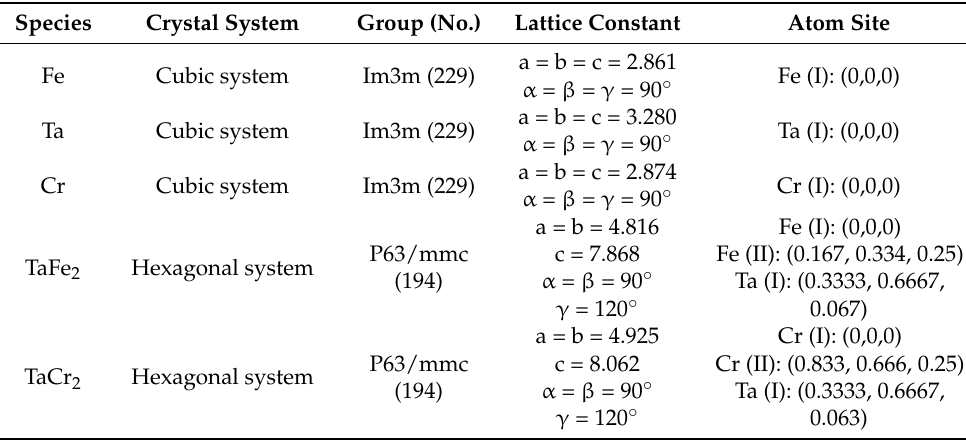
Figure 3. Fe ( a ), Ta ( b ), Cr ( c ), TaFe 2 ( d ), and TaCr 2 ( e ) crystalline cell structure. Table 5. Structural parameters of Fe, Ta, TaFe2, and TaCr2. Table 5. Structural parameters of Fe, Ta, TaFe 2 , and TaCr 2